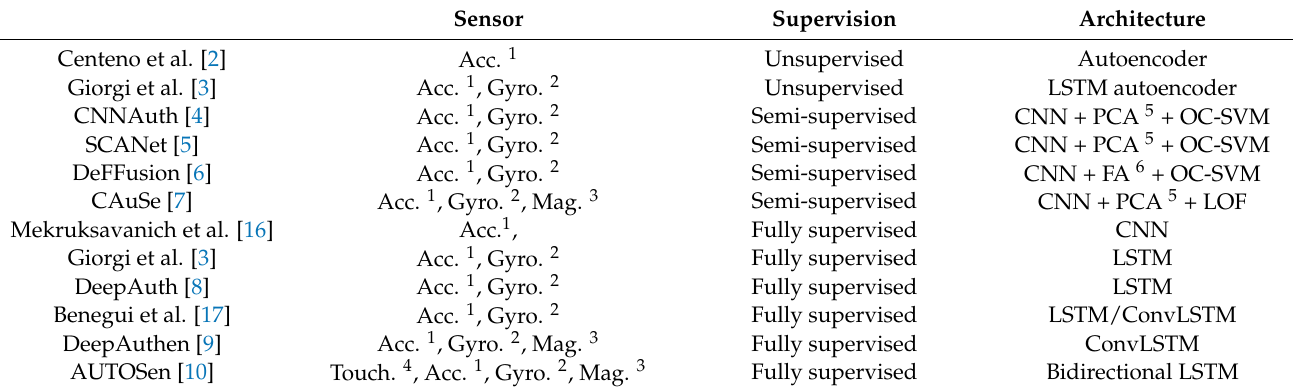
Table 1. End-to-end models for mobile-based biometrics. Sensor